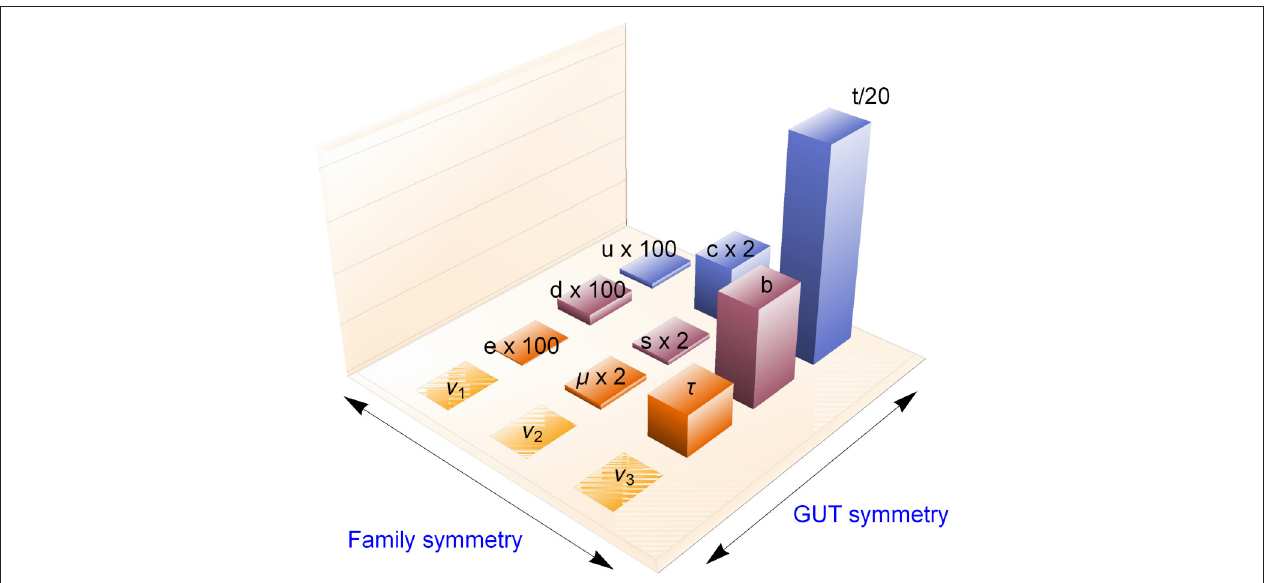
FIGURE 6 | Action of the GUT and family symmetry groups. Given the large hierarchies, the height of the columns are not in scale and the actual values of the fermion masses have been multiplied or divided by the factors on top of each columns.